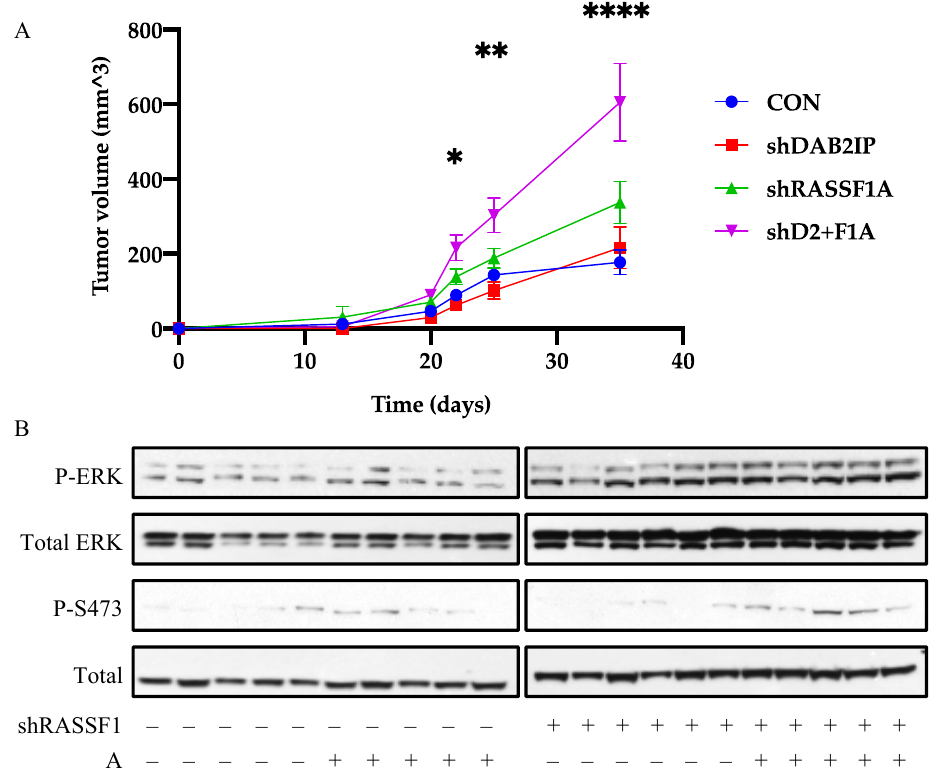
D Figure 5. Cont